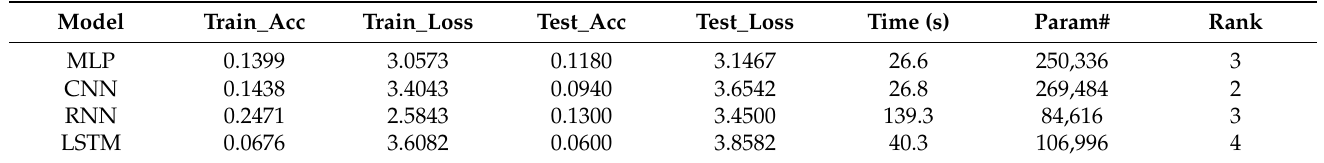
Table 2. Specific parameters and experimental results of each